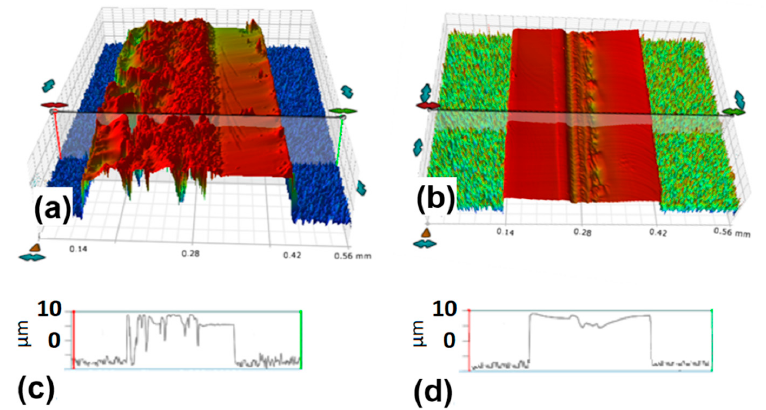
Figure 6 . Three ‐ dimensional profiles and line profiles of the cuts obtained at 50 kHz, scan speed of 1 mm/s and pulse energy of ( a , c ) 35 μ J and ( b , d ) 20 μ J, respectively.